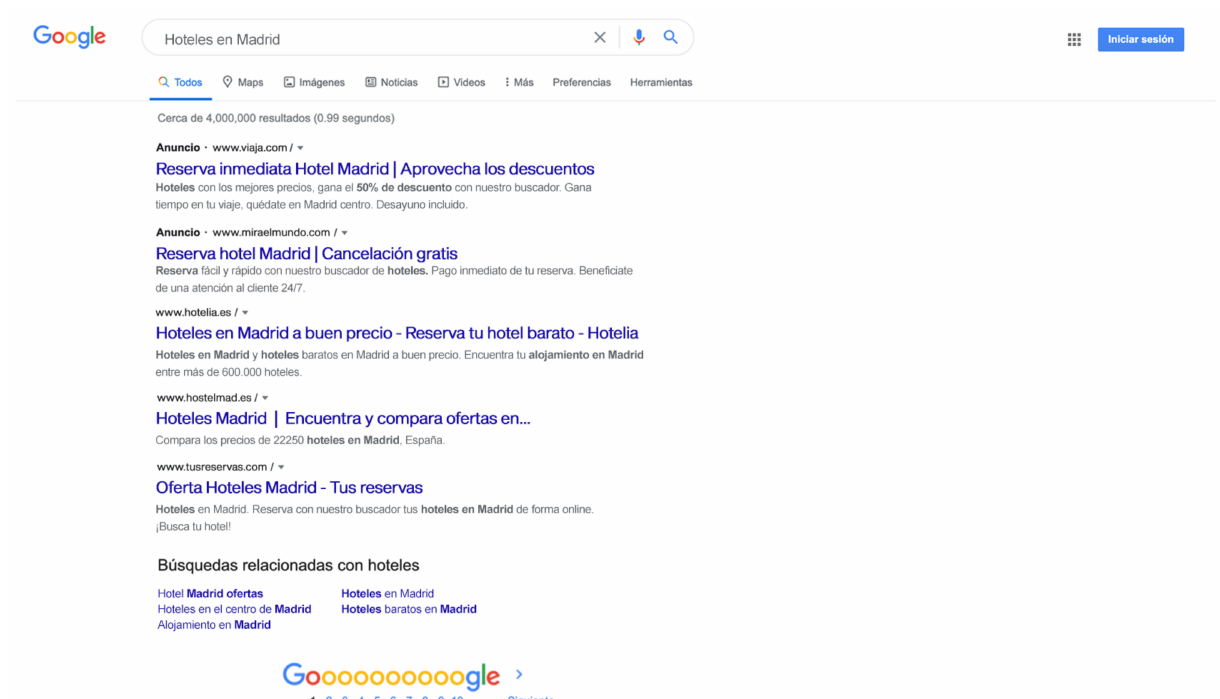
Figure 2. Promotion fit condition